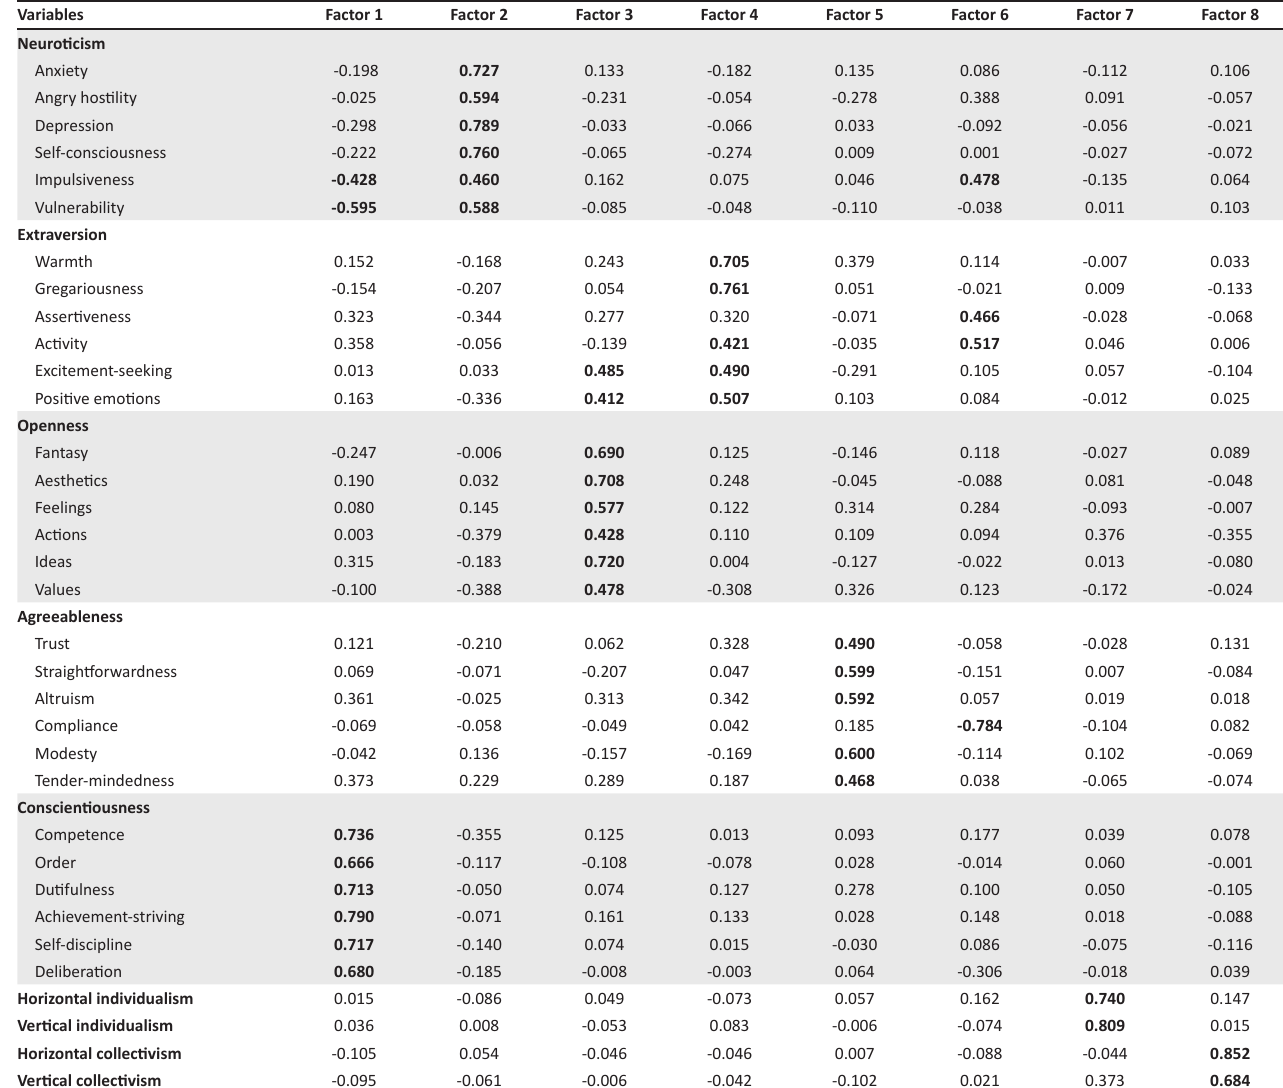
TABLE 6: Eight-factor solution for the joint factor analysis of the NEO-PI-3 and the individualism and collectivism dimensions. Variables